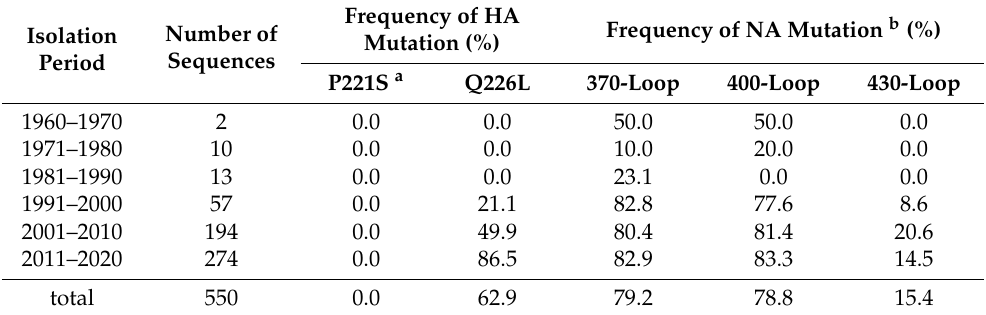
Table 2. Frequency of identified amino acid changes in HA and NA of H9N2 AIVs in each time period. Isolation